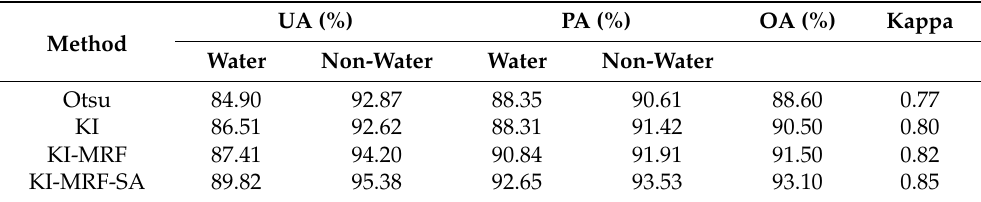
Table 2. Accuracy assessment of water and non-water delineation using different